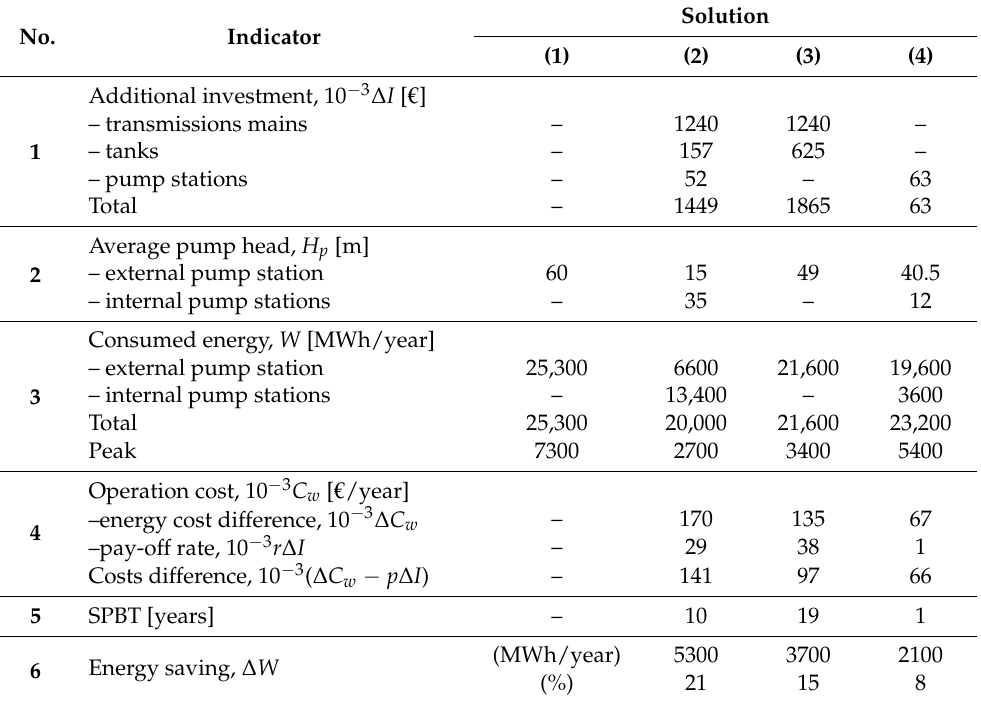
Table 4. Energy–economic indicators of analysed